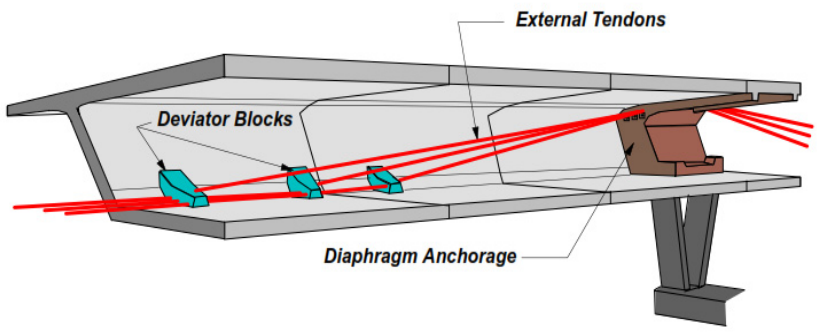
Figure 1. Layout of an externally post-tensioned box girder bridge.